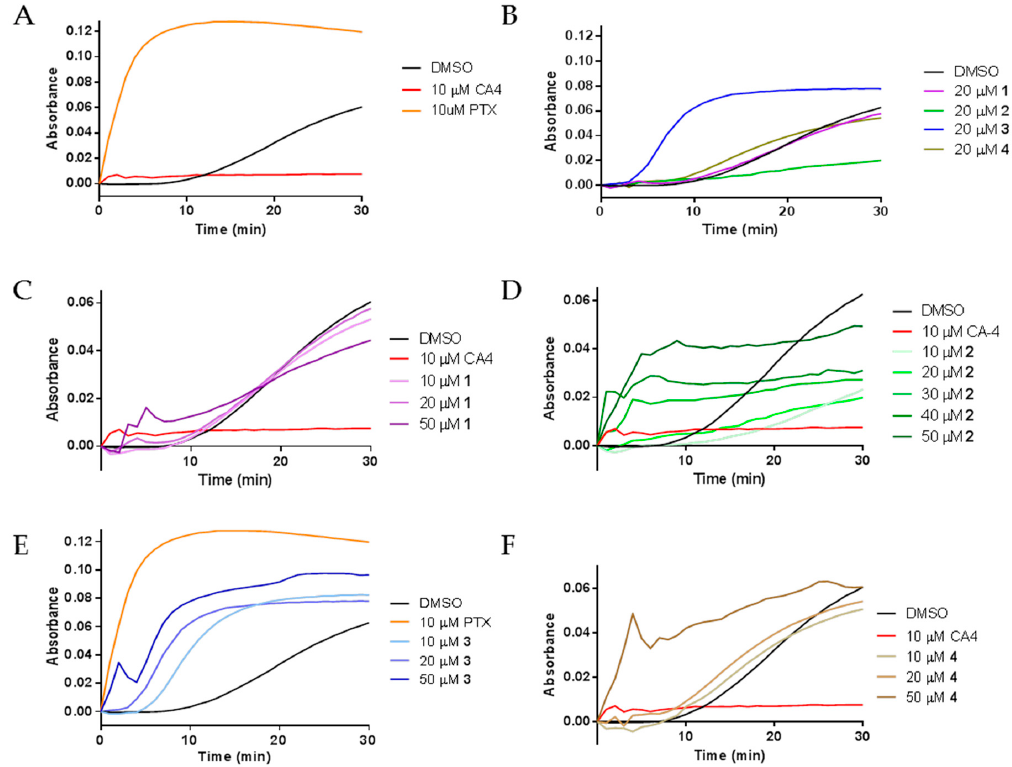
Figure 4. The effects of 1 – 4 on tubulin polymerization: ( A ) the polymerization of purified porcine brain tubulin was monitored by absorbance at 340 nm after incubation with vehicle (DMSO), 10 μ M CA-4, or 10 μ M paclitaxel (PTX); ( B ) effects of 1 – 4 on tubulin polymerization at stoichiometric concentrations